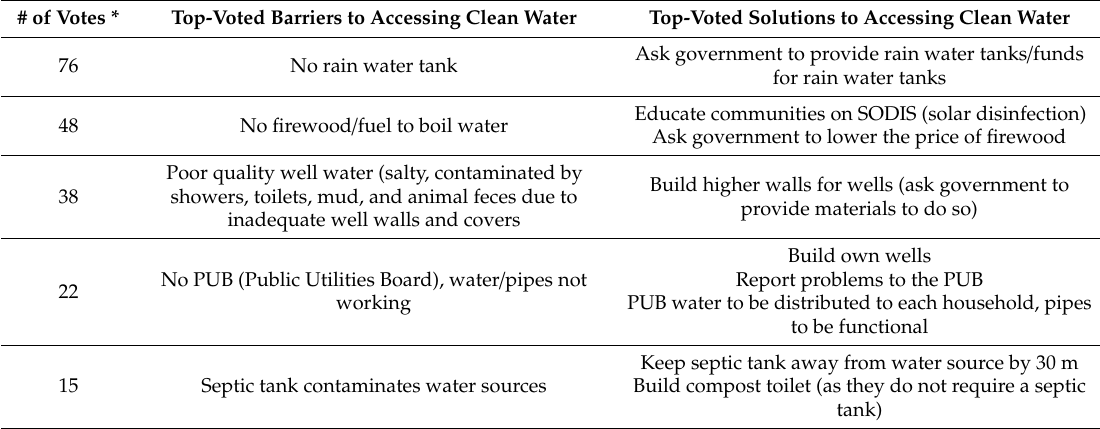
Table 9. Top-voted barriers and solutions to clean water access in South Tarawa